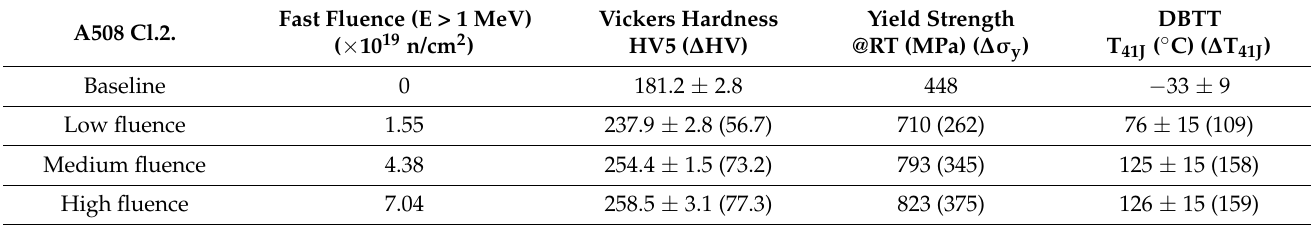
Table 3. Fast fluence (E > 1 MeV), Vickers hardness (HV5), yield strength (hardening ∆ σ y ), and ductile to brittle transition temperature (DBTT; embrittlement ∆ T 41J ) for A508 Cl.2. RT, room temperature. A508 Cl.2.